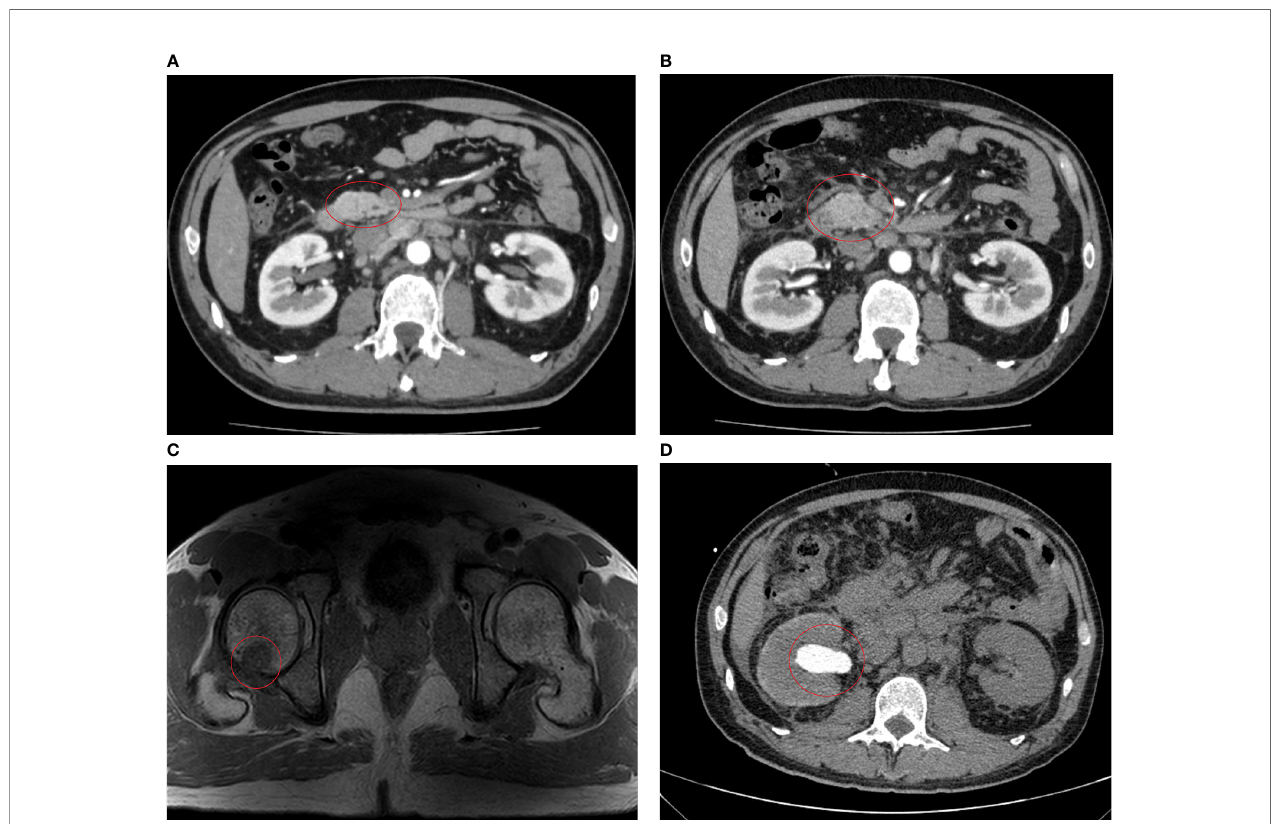
FIGURE 3 | Imaging examinations performed after chemotherapy. (A) After fi ve cycles of XELOX, CT scans on August 12, 2020 revealed enlargement of the abdominal para-aortic and bilateral para-iliac lymph nodes, about 0.5 – 1.5 cm, with slightly enhanced. (B) After six cycles of FOLFIRI plus cetuximab treatment, CT scans on November 28, 2020 revealed signi fi cant enlargement of lymph nodes in the hilar area, adjacent to the abdominal aorta, and bilateral iliac vessels, with a maximum of about 2.3 cm and slightly enhancement. (C) MRI scans on November 29, 2020 show patchy shadows are seen on the right femoral head and greater trochanter, enhanced scans are seen to be enhanced, consider metastasis. (D) CT scans on December 22, 2020 showed hydronephrodilation of the right renal pelvis and space-occupying lesion about 16.2 mm × 9.3 mm in the initial segment of the right